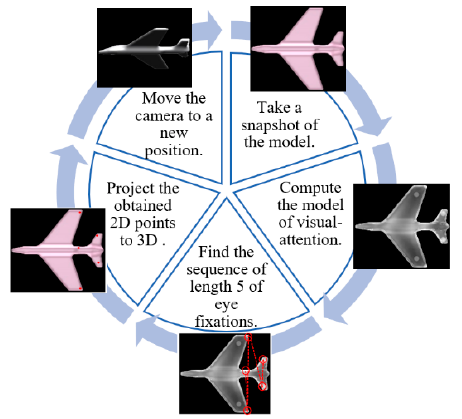
Figure 2. Determination of the sequence of eye fixations for each viewpoint.